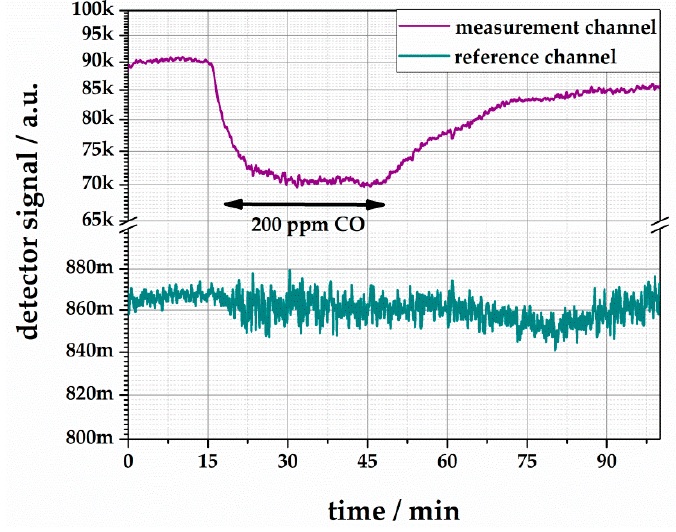
Figure 9. Colorimetric reaction of 1 · (A) 2 adsorbed on silica gel to 100 ppm CO with 40% r.H. at room temperature.